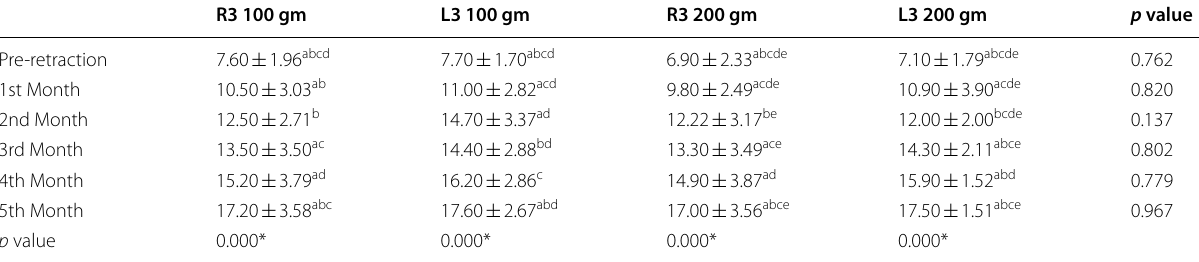
Means with the same superscript letters in column are significantly different at p ˂ 0.05 according to the least significant test (LSD) test. *Statistically significant at p value ˂ 0.05